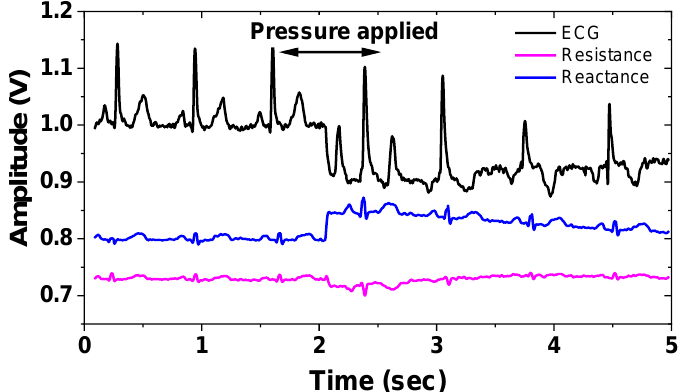
Figure 26. Measured result of band power channels. Positive and negative inputs are indicated with blue and red lines, and output is indicated with black lines.